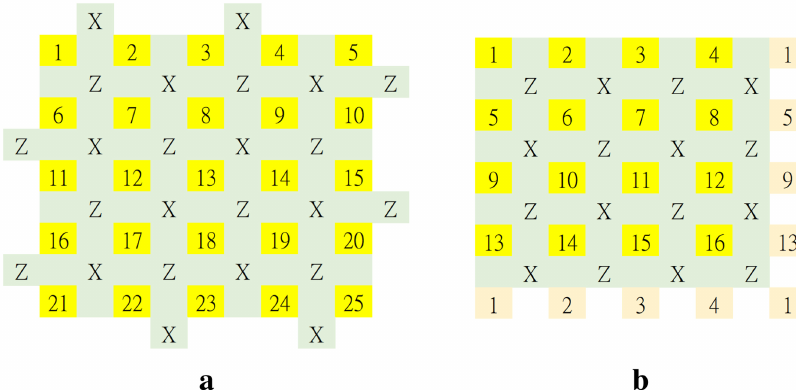
Fig. 4 The lattice representations of (rotated) surface and toric codes. a [[ L 2 , 1, L ]] surface code with L = 5. b [[ L 2 , 2, L ]] toric code with L = 4. In both fi gures, a qubit is represented by a yellow box numbered from 1 to N . Since the toric code is de fi ned on a torus, there are orange boxes on the right and bottom in b , each representing the qubit of the same number. An X - or Z -type stabilizer is indicated by a label W ∈ { X , Z } between its neighboring qubits. For example, in a , the label X between qubits 1 and 2 is X 1 X 2 and the label Z between qubits 1, 2, 6, and 7 is Z 1 Z 2 Z 6 Z 7 .